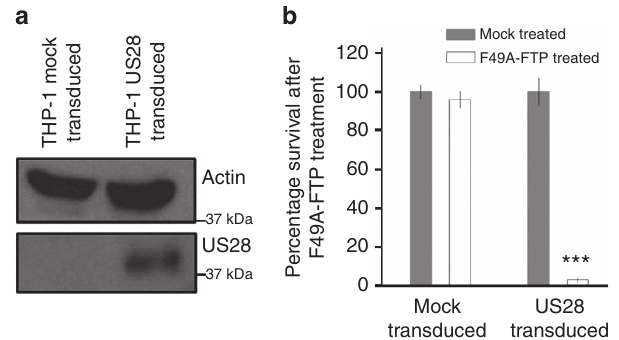
Figure 2 | F49A-FTP kills monocyte-like THP-1 cells that express US28. THP-1 cells expressing HA-US28 were generated by lentiviral transduction and puromycin selection. ( a ) Western blots of cell lysates from transduced THP-1 cells against the N-terminal HA tag on HA-US28, control cells were mock transduced. ( b ) THP-1 cells expressing HA-US28, or control cells, were treated with 5 (cid:2) 10 (cid:3) 8 M F49A-FTP for 48h. Cell death was quantified by Trypan blue staining. Means and error bars (showing s.d.) were generated from seven independent experiments. Statistical analyses were carried out using a paired two-tailed t -test and *** P ¼ 0.001 were considered